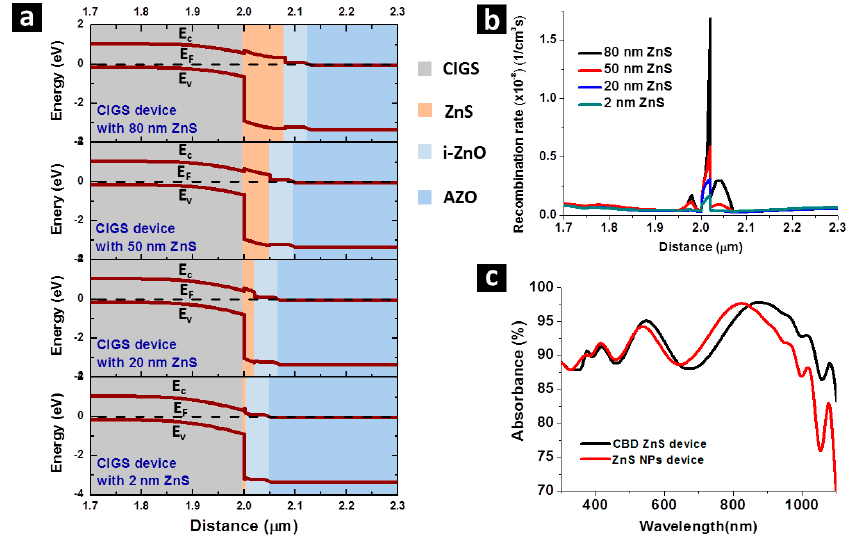
Figure 6. Calculated ( a ) band diagram, and ( b ) carrier recombination rate around CIGS/ZnS interface of CIGS solar cell with 2 nm, 20 nm, 50 nm and 80 nm ZnS buffer layer. ( c ) Absorbance spectra of CIGS solar cells with CBD ZnS buffer layer and ZnS NPs buffer layer.